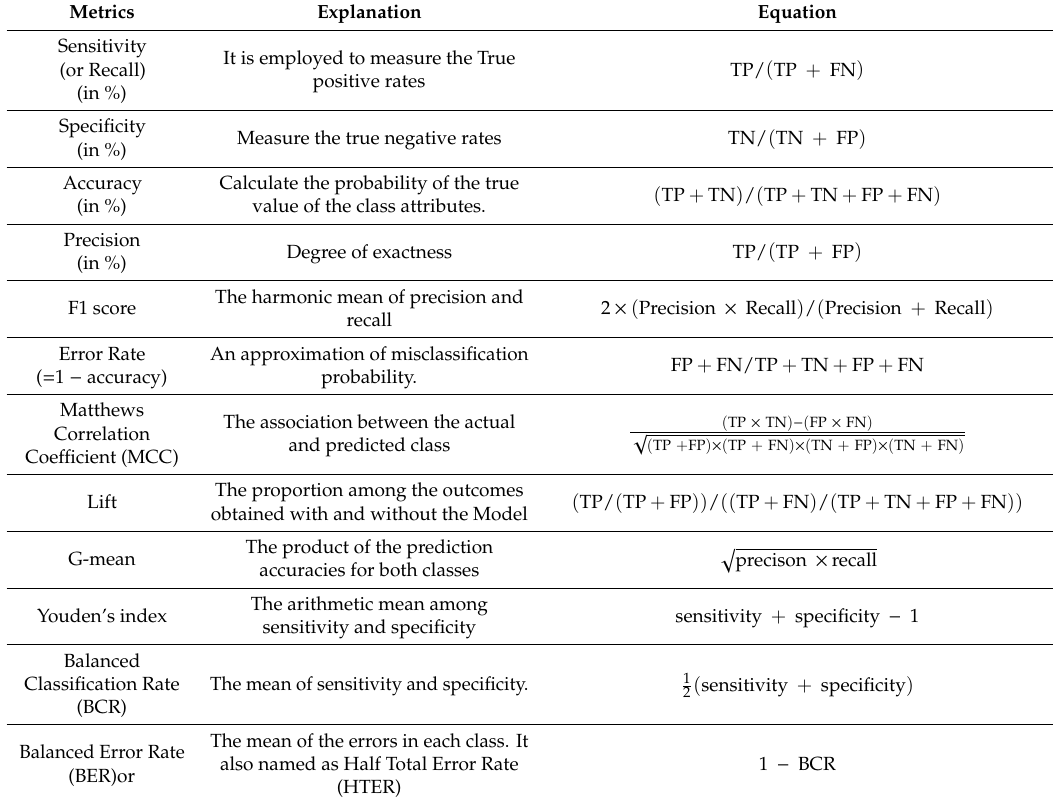
Table 5. Detailed interpretations for various classification